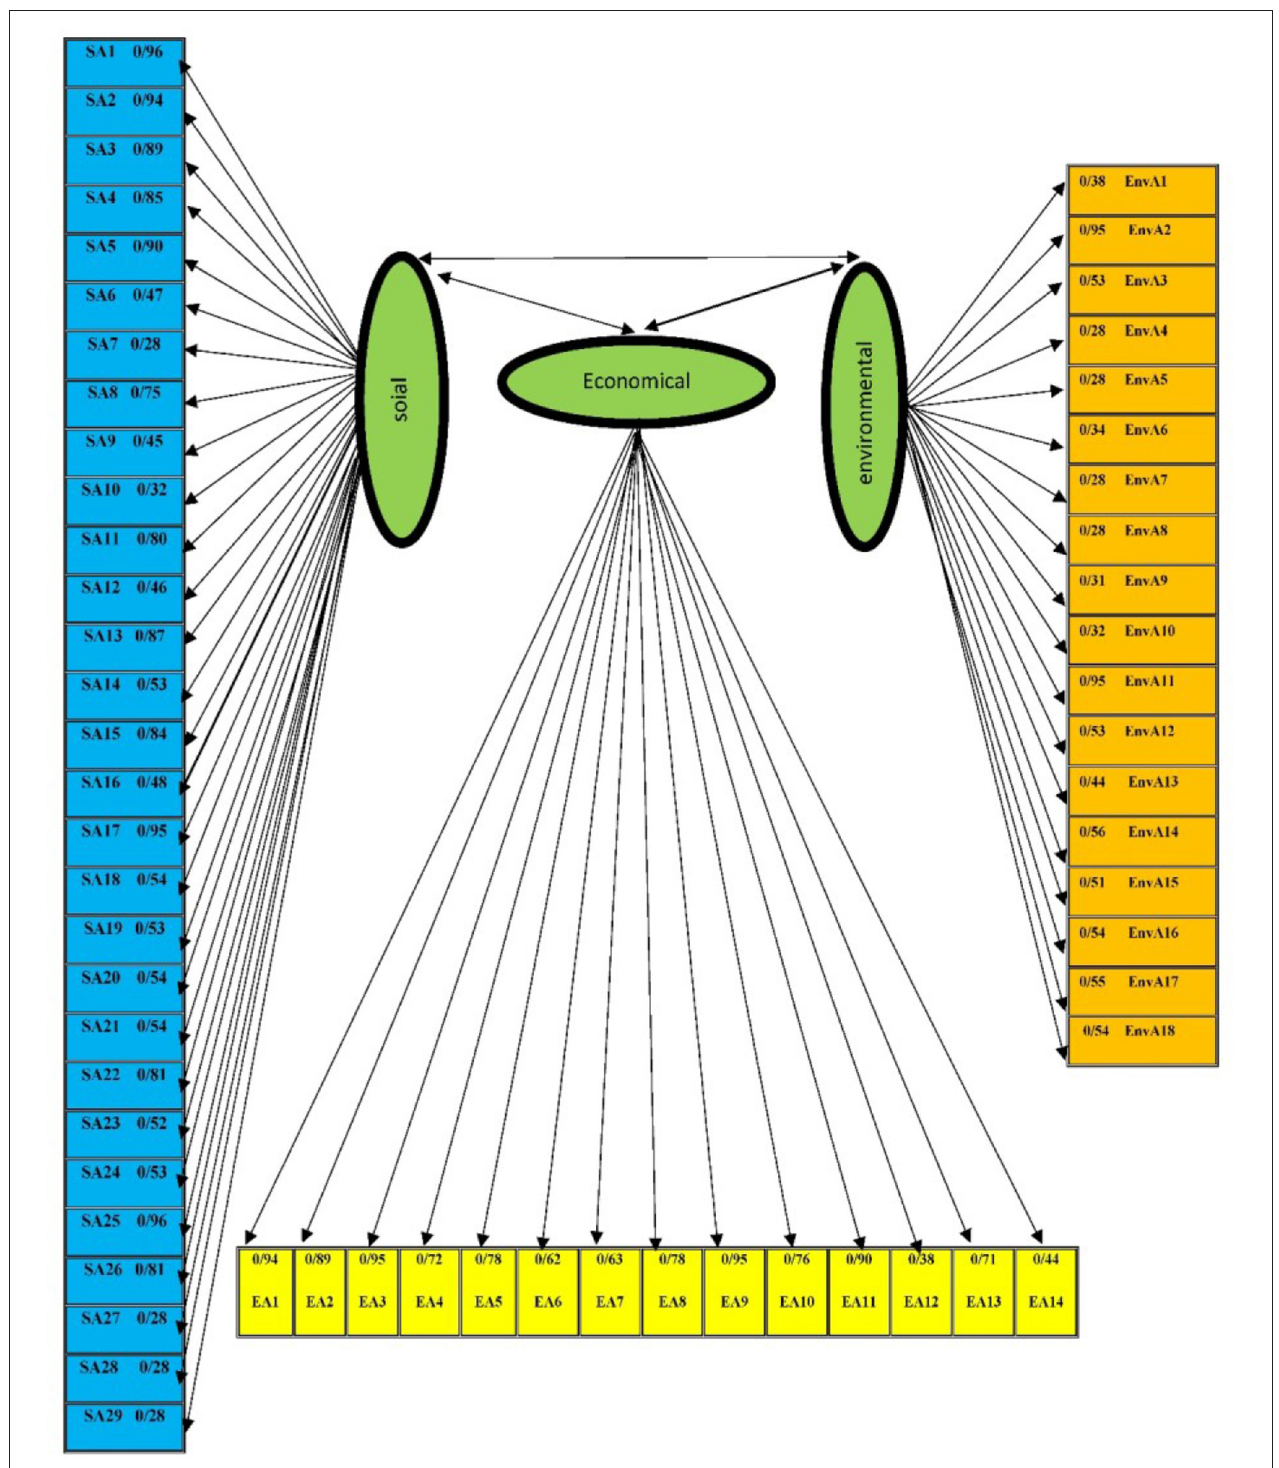
FIGURE 1 | Estimate Model. Chi-square = 3612.23; df = 1775; P–value = 0.0000; RMSEA = 0.067.